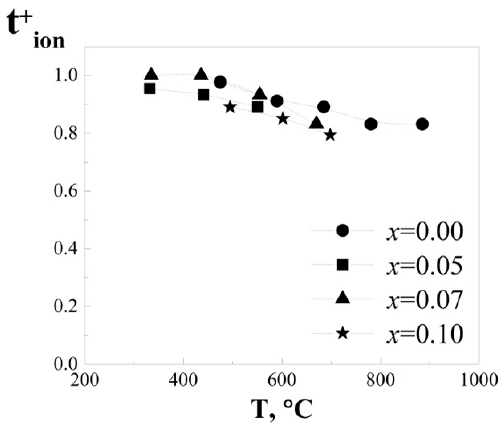
Figure 10. The values of the ion transfer numbers for (1- x )Gd 2 Zr 2 O 7 · x MgO ( х = 0, 0.05, 0.07, 0.10).